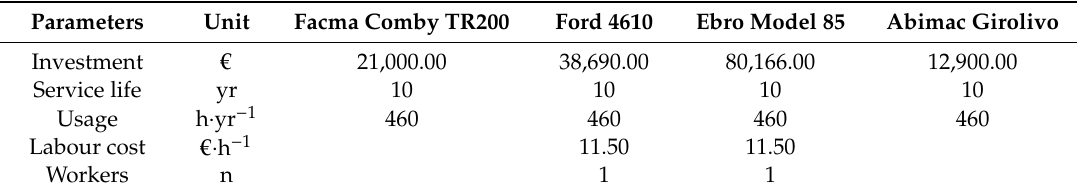
Table 2. Main economic parameters used for the economic